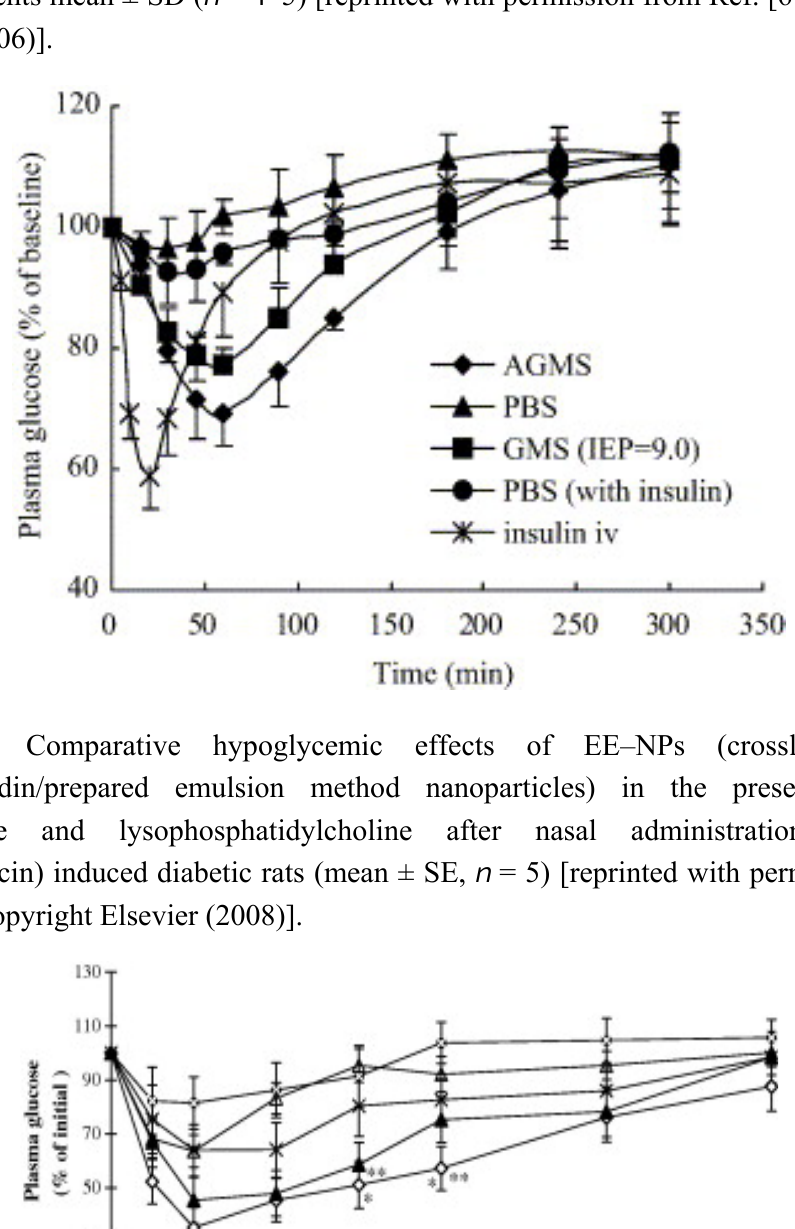
Figure 2. Changes of plasma glucose levels after intravenous administration of insulin solution and intranasal administration of insulin-incorporated gelatin (GMS) and aminated gelatin microspheres (AGMS) in dry powder forms. The dose of insulin was 0.5 IU/kg for intravenous route and 5 IU/kg for intranasal route (PBS-phosphate buffer saline). Each point represents mean ± SD ( n = 4–5) [reprinted with permission from Ref. [64], copyright Elsevier (2006)].